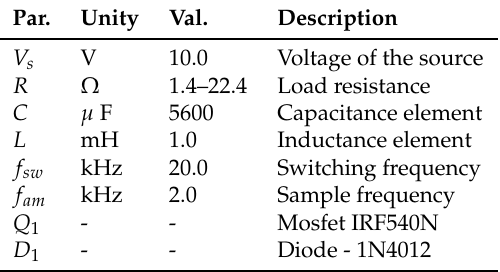
Table 1. Main parameters of the experimental system developed Par. Unity Val. Description V s 10.0